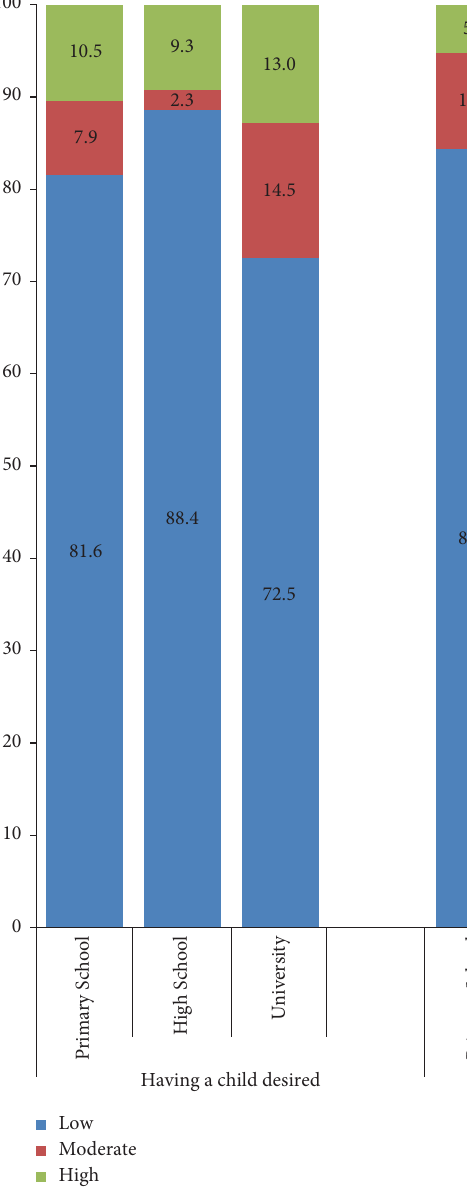
Figure 1: Associations of current desire to have children, chance of a future spontaneous pregnancy, and chance of a future pregnancy with fertility preservation treatment according to education